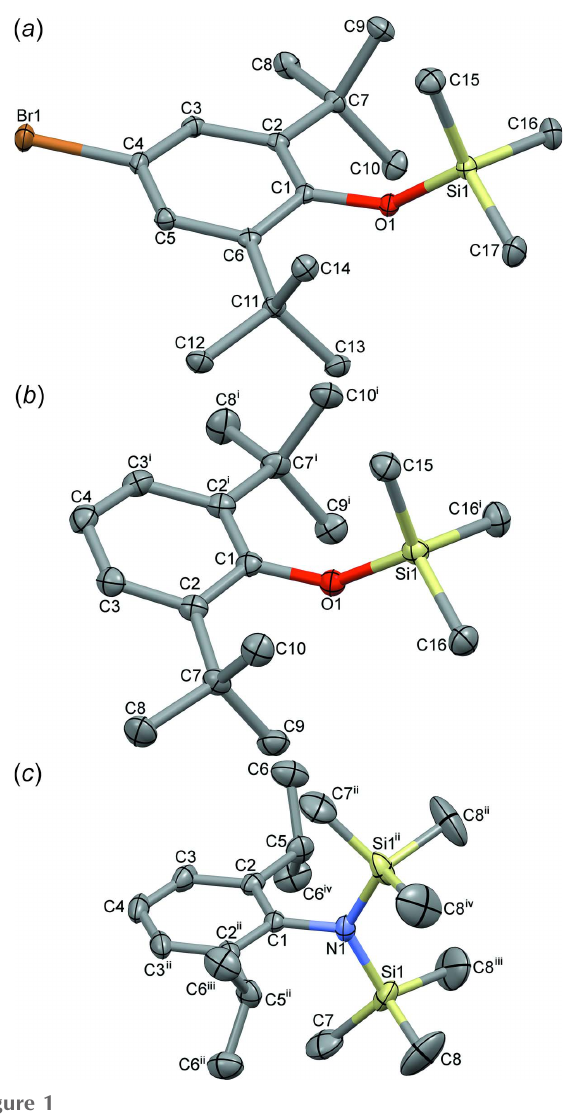
Figure 1 Displacement ellipsoids plot of the molecular structures of ( a ) (I) at the 50% probability level; ( b ) (II), also at the 50% probability level, and ( c ) (III) at the 40% probability level. H atoms have been omitted and the atom numbering schemes are shown. [Symmetry codes: (i): x , 1 (cid:2) z ; (iii) x , y , 3 (cid:2) z ; (iv) 1 (cid:2) x , y , z 1 (cid:2) x , y , 3 2 2